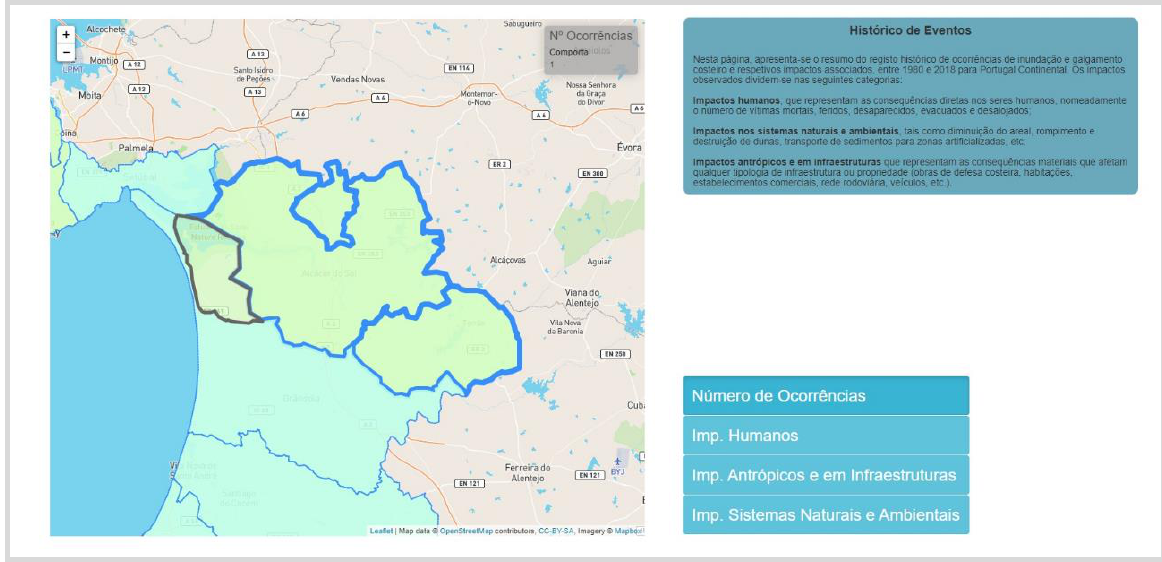
Figure 8. View of the Historical Data of Coastal Flooding Occurrences page when “number of occurrences” ( número de ocorrências ) is selected as variable and Alcácer do Sal is the county selected on the map.